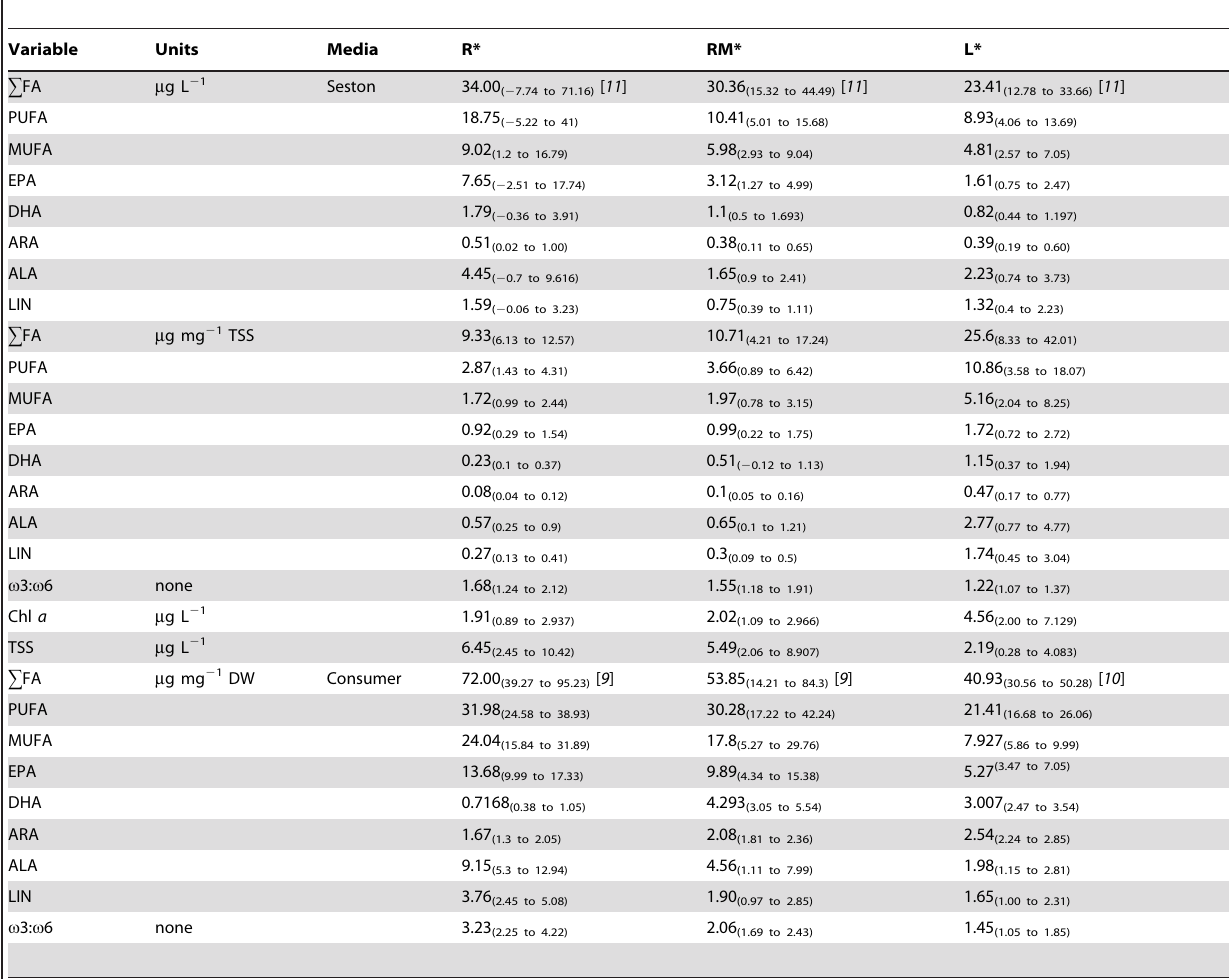
Table 1. Mean and 95% credible intervals of seston and consumer response variables sampled at river (R), rivermouth (RM) and nearshore lake (L) sites (number of sites indicated in [brackets]